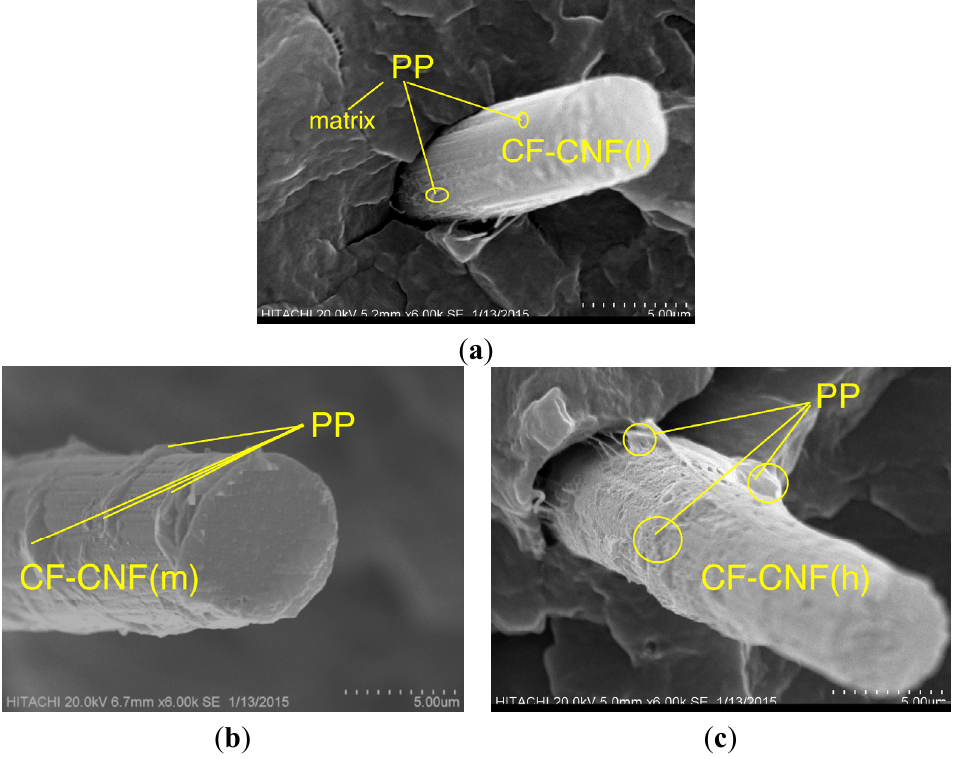
Figure 9. SEM micrographs of fractured surface of ( a ) CF-CNF L /PP, ( b ) CF-CNF M /PP, and ( c ) CF-CNF H /PP